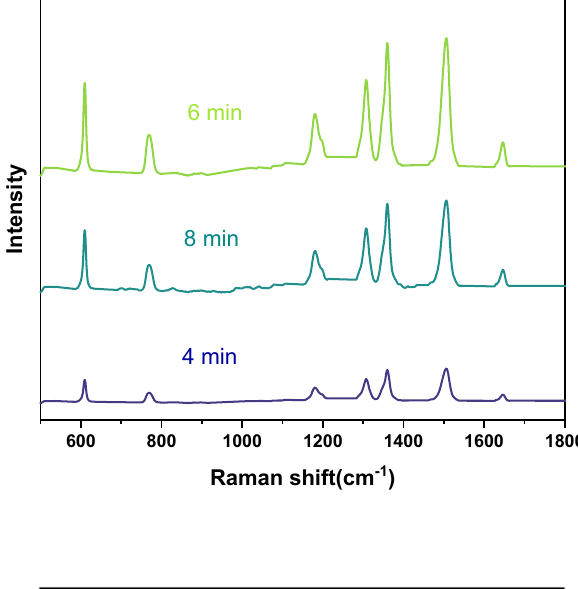
Fig. 4 Raman spectrum of 10 –2 –10 −10 M